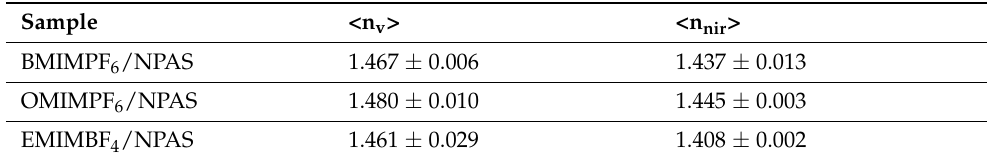
Figure 4. Wavelength dependence of refraction index for BMIMPF 6 /NPAS (red solid line), OMIMPF 6 /NPAS (green solid line), and EMIMBF 4 /NPAS (blue solid line) samples and the NPAS support (black dashed line). Table 4. Average values of refractive index (n) for the studied samples for the visible (v) and near-infrared (nir) regions.